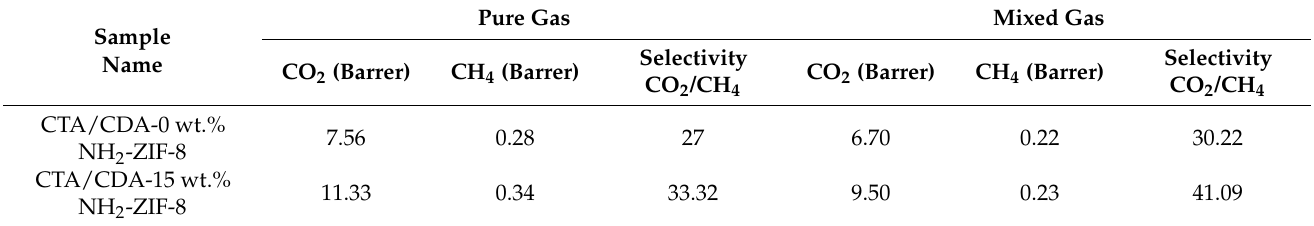
Table 3. Comparison of pure gas and mixed gas separation performance.